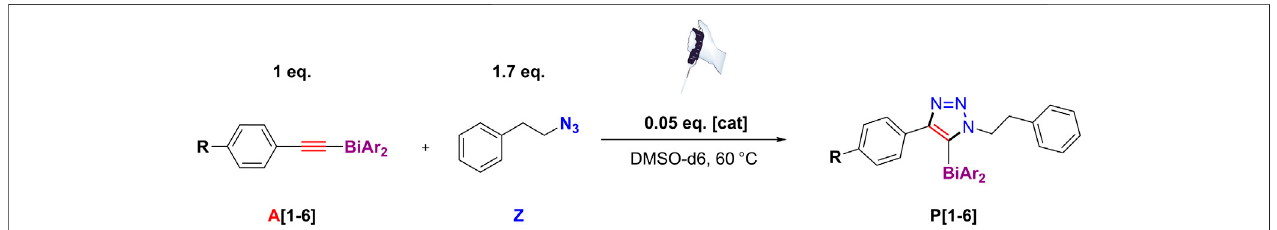
FIGURE8| Cyclicvoltammogramkineticstudiesofbismuth(III) acetylide in the presence of the copper(I) tri fl uoromethanesulfonate toluene complex at 25 ° C in dry DMF at 100 mV/sec. Conditions: 3-electrode cell with glassy carbon as the working electrode, copper foils as counter, and reference